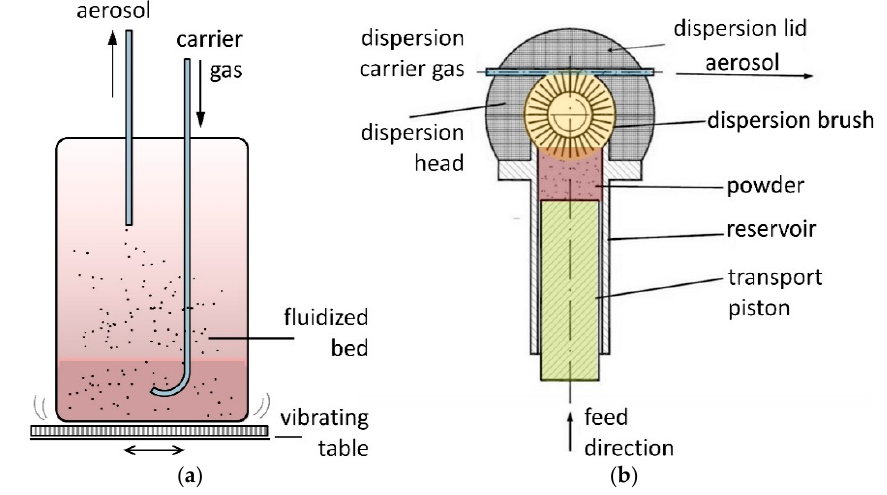
Figure 2. Working principle of ( a ) a fluidized bed generator and ( b ) of a powder dispersion unit with brush generator, modified after [25]. brush generator, modified after [25].